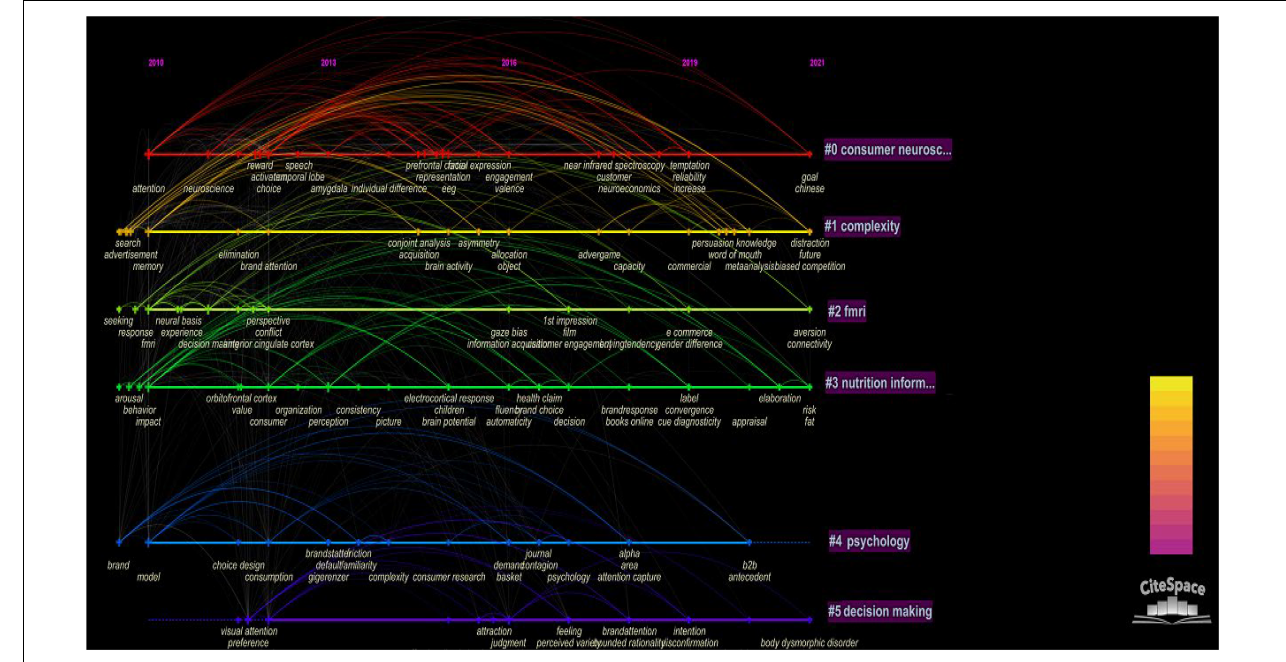
FIGURE 2 | Timeline of the “Neuromarketing” cited